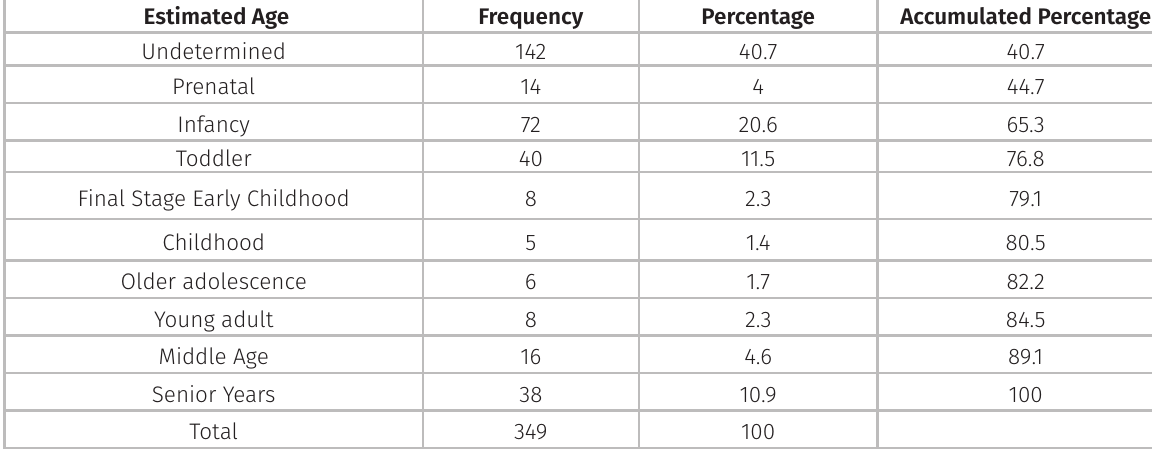
Table VII. Consolidated information about age at death